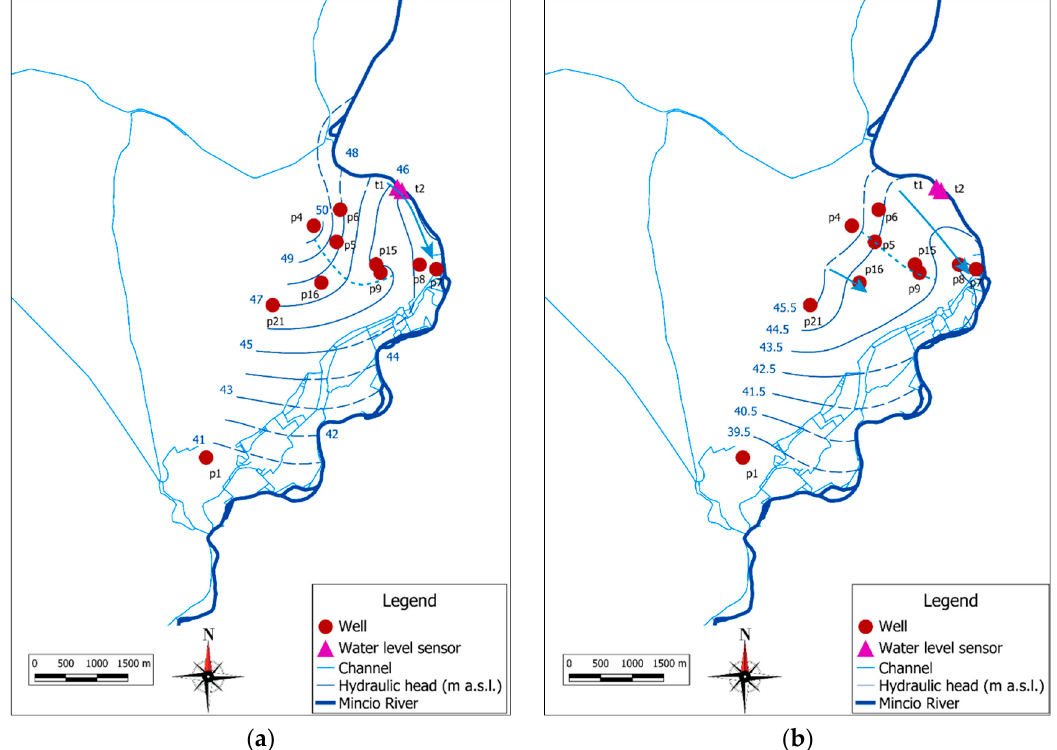
Figure 5. Net groundwater flow during irrigation (July 2019) ( a ) and non-irrigation (December 2019) ( b ) periods.